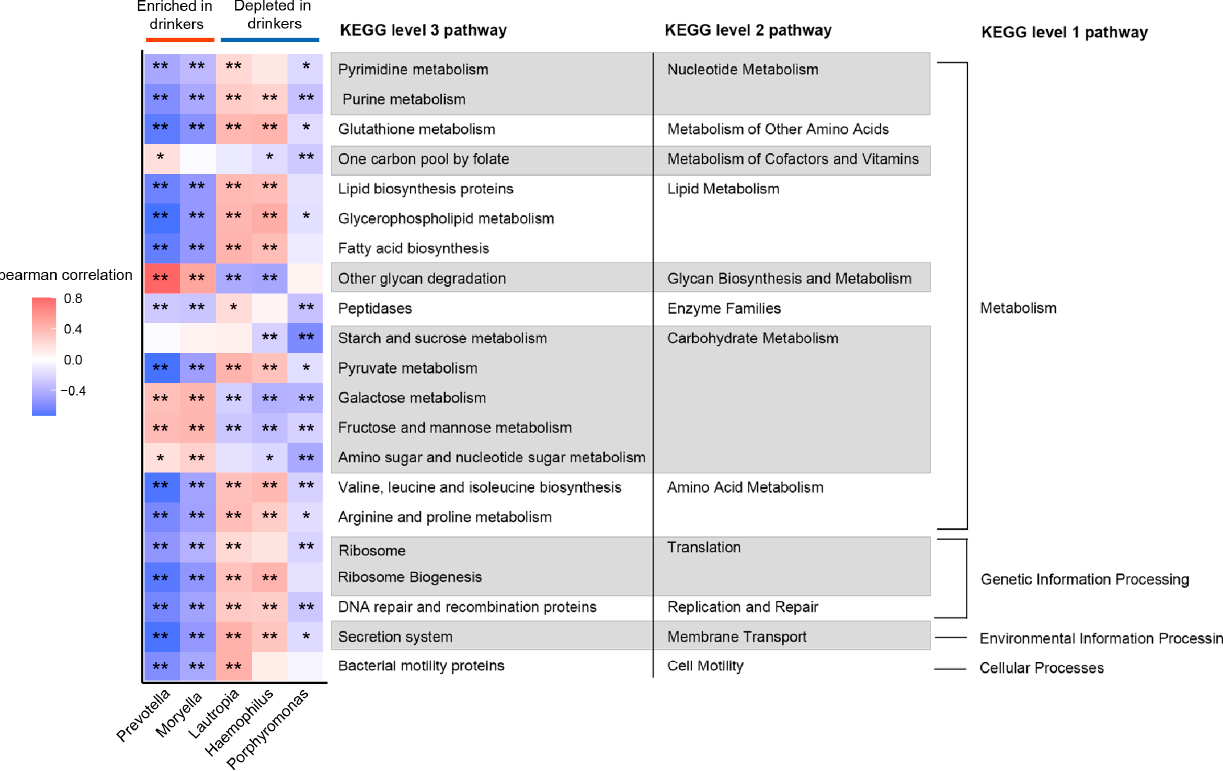
Figure 3. The genera associated with drinking status are related to several gene functional pathways. Spearman’s correlation coefficients were estimated for each pairwise comparison of genus counts and KEGG pathway counts. The strength of the color depicts Spearman’s correlation coefficients (negative score, blue; positive score, red). * p < 0.05, ** p < 0.01.